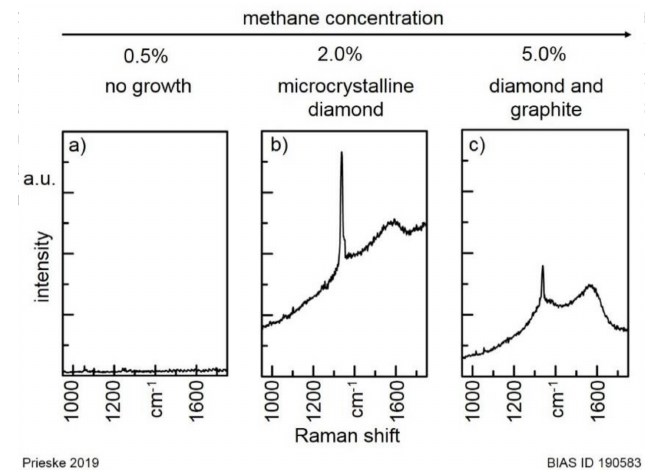
Figure 4. Raman spectra of coatings deposited at the process temperature of 1050 ◦ C and di ff erent methane concentrations: ( a ) 0.5%; ( b ) 2.0% and ( c )